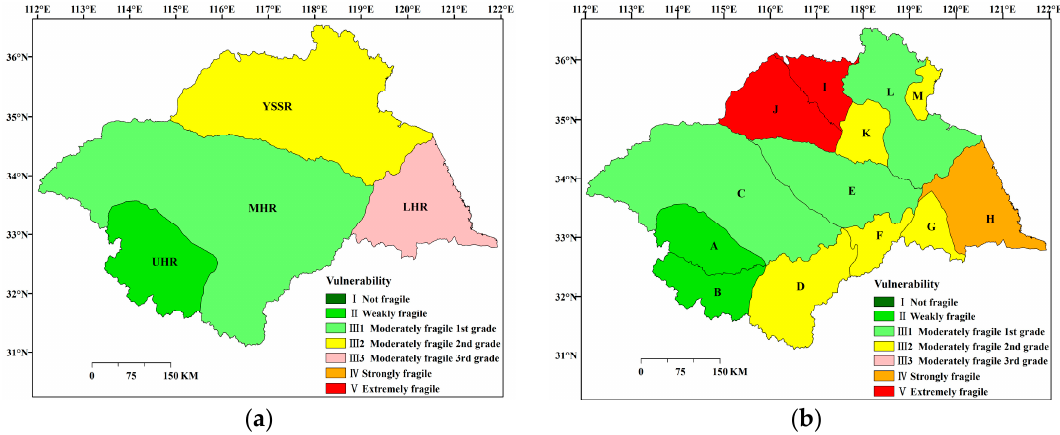
Figure 4. Average water resource vulnerability in the Huai River Basin. ( a ) Vulnerability at the Class II WRR scale; ( b ) Vulnerability at the Class III WRR scale. A, North shore above the Wangjia Dam; B, South shore above the Wangjia Dam; C, North shore between the Wangjia and Bengbu Dam; D, South shore between the Wangjia and Bengbu Dam; E, North shore between Bengbu Dam and Hongze Lake; F, South shore between Bengbu Dam and Hongze Lake; G, Gaotian district area; H, the Lixia River Basin; I, eastern areas of the southern four lakes; J, western areas of the southern four lakes; K, the areas of the median Grand Canal; L, Yi ‐ Shu ‐ Si River Basin; M, the Rigan district area.